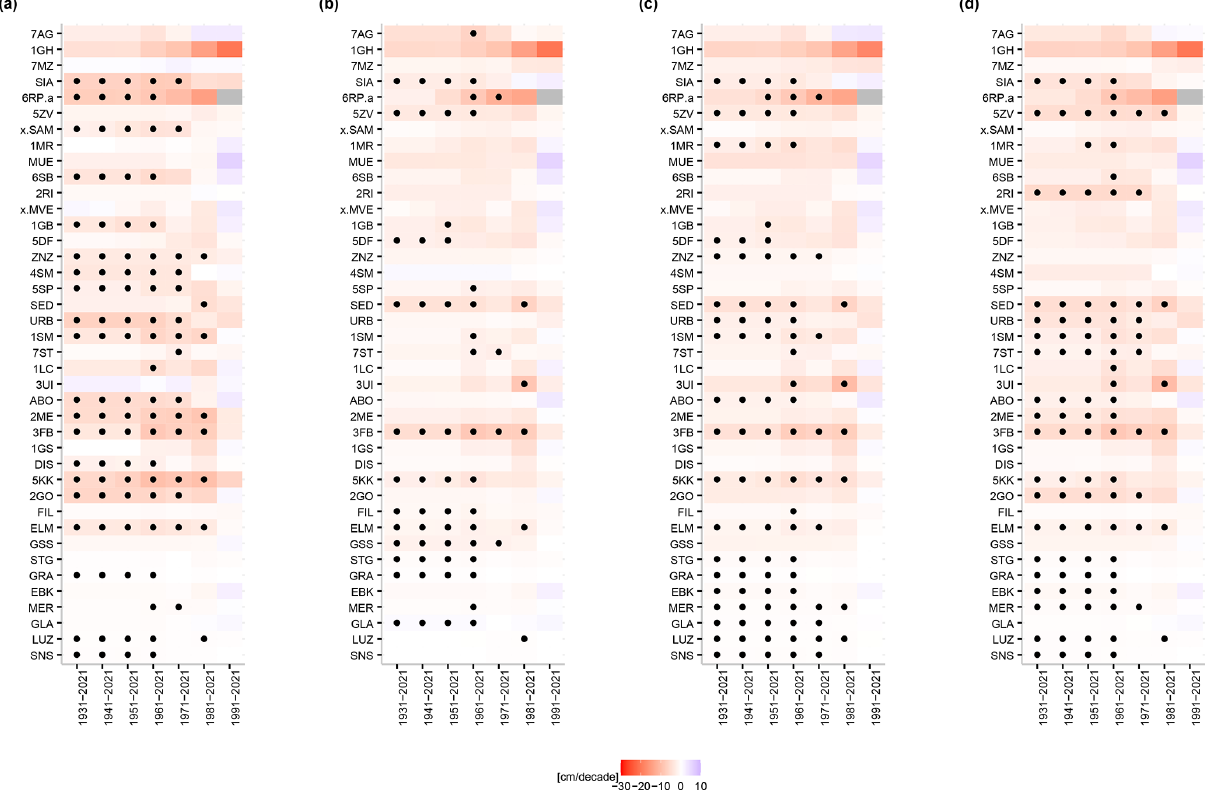
Figure A2. Trends for HSavg: shown are all methods and all decades. Original (a) , HOMER (b) , Climatol (c) , and interpQM (d) .